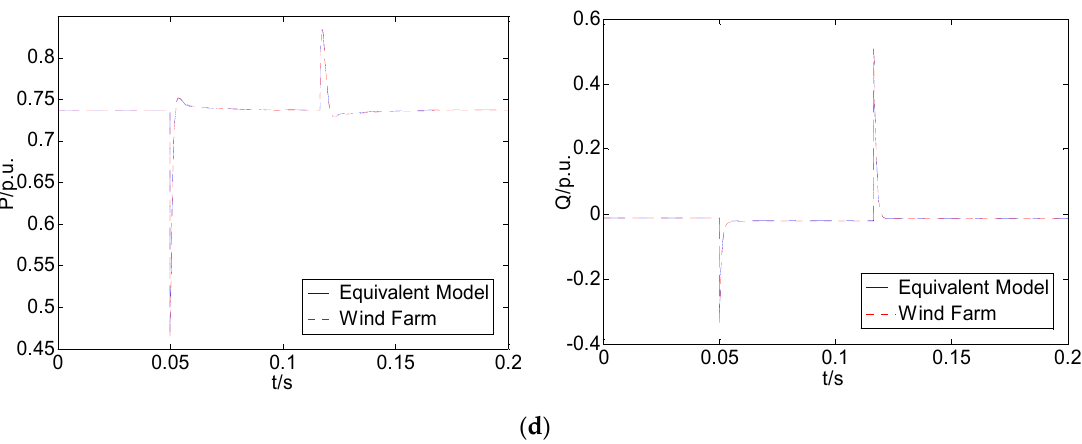
Figure 7. Descriptive capability of equivalent model: ( a ) comparison response for wind speed is 8 m/s; ( b ) comparison response for wind speed is 9 m/s; ( c ) comparison response for wind speed is 10 m/s; and ( d ) comparison response for wind speed is 11 m/s.